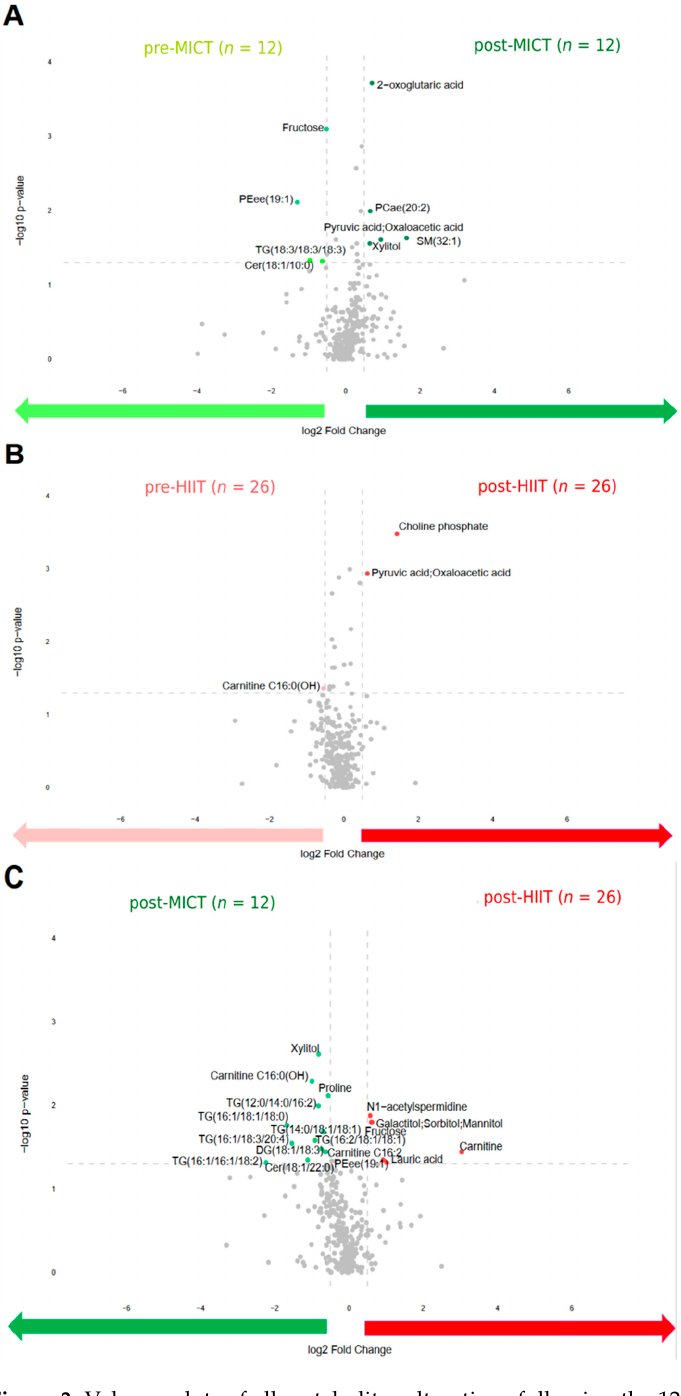
Figure 3. Volcano plots of all metabolites alterations following the 12-week intervention, showing the relationship between fold change (log2 Fold Change; horizontal axis) and significance ( − log10 p -value; vertical axis). Fold changes describe alterations comparing: pre to post MICT ( A ); pre to post HIIT ( B ); post MICT to post HIIT ( C ). Pre: before the 12-week intervention; Post: after the 12-week intervention; MICT: moderate-intensity continuous training; HIIT: high-intensity interval training. Metabolites shown as light green and dark green points refer to the metabolites upregulated abundance before MICT and after MICT respectively. Metabolites shown as light red and dark red points refer to the metabolites upregulated abundance before HIIT and after HIIT